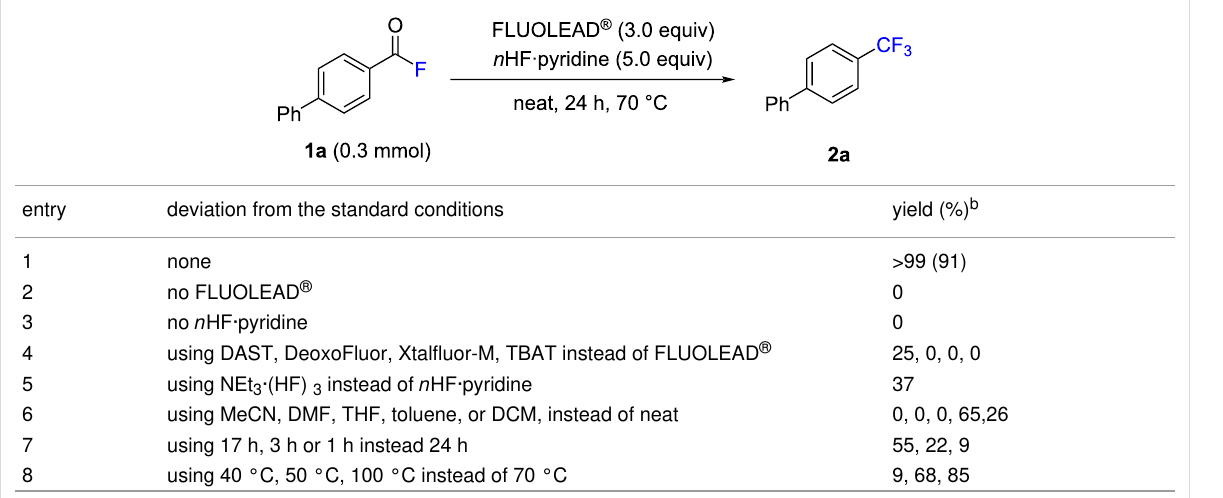
Table 1: Optimizing the reaction conditions for the conversion of 1a a .